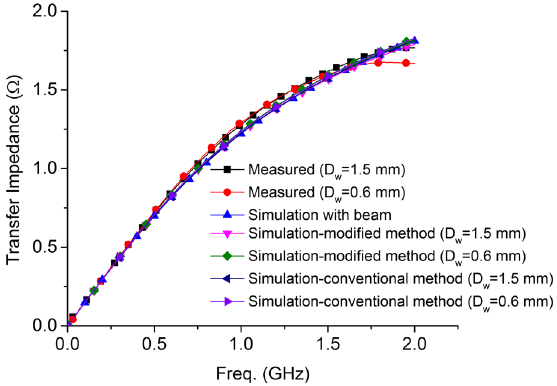
FIG. 18. Comparison of the transfer impedance of IDBPI obtained experimentally with